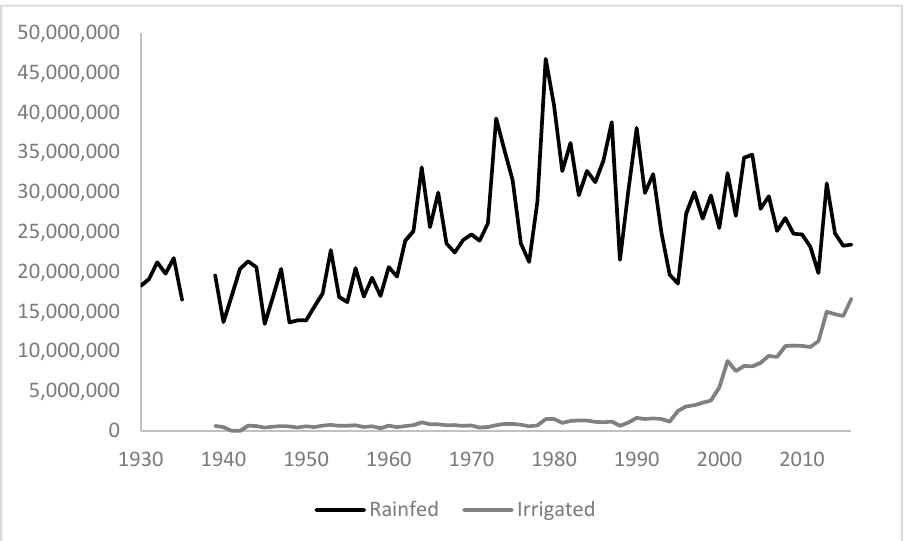
Figure 2. Evolution in Spain of wine production from rainfed and irrigated wine grape vineyards, Table 2. Average wine production of rainfed and irrigated vineyard areas (in